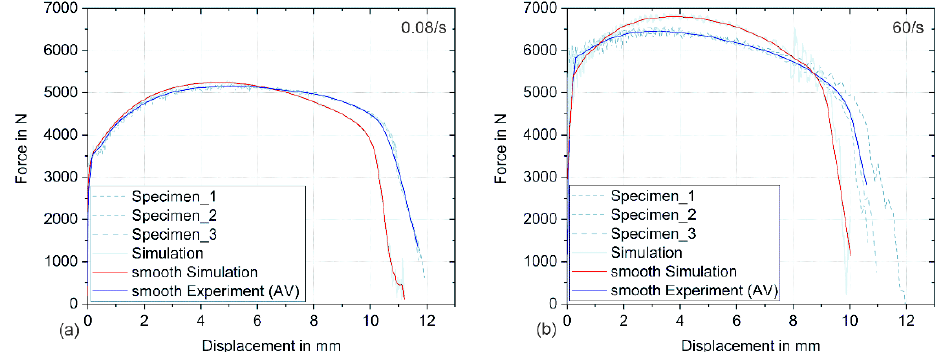
Figure 12. Logarithmic dependence of strain rate and yield strength for three different degrees of true strain.